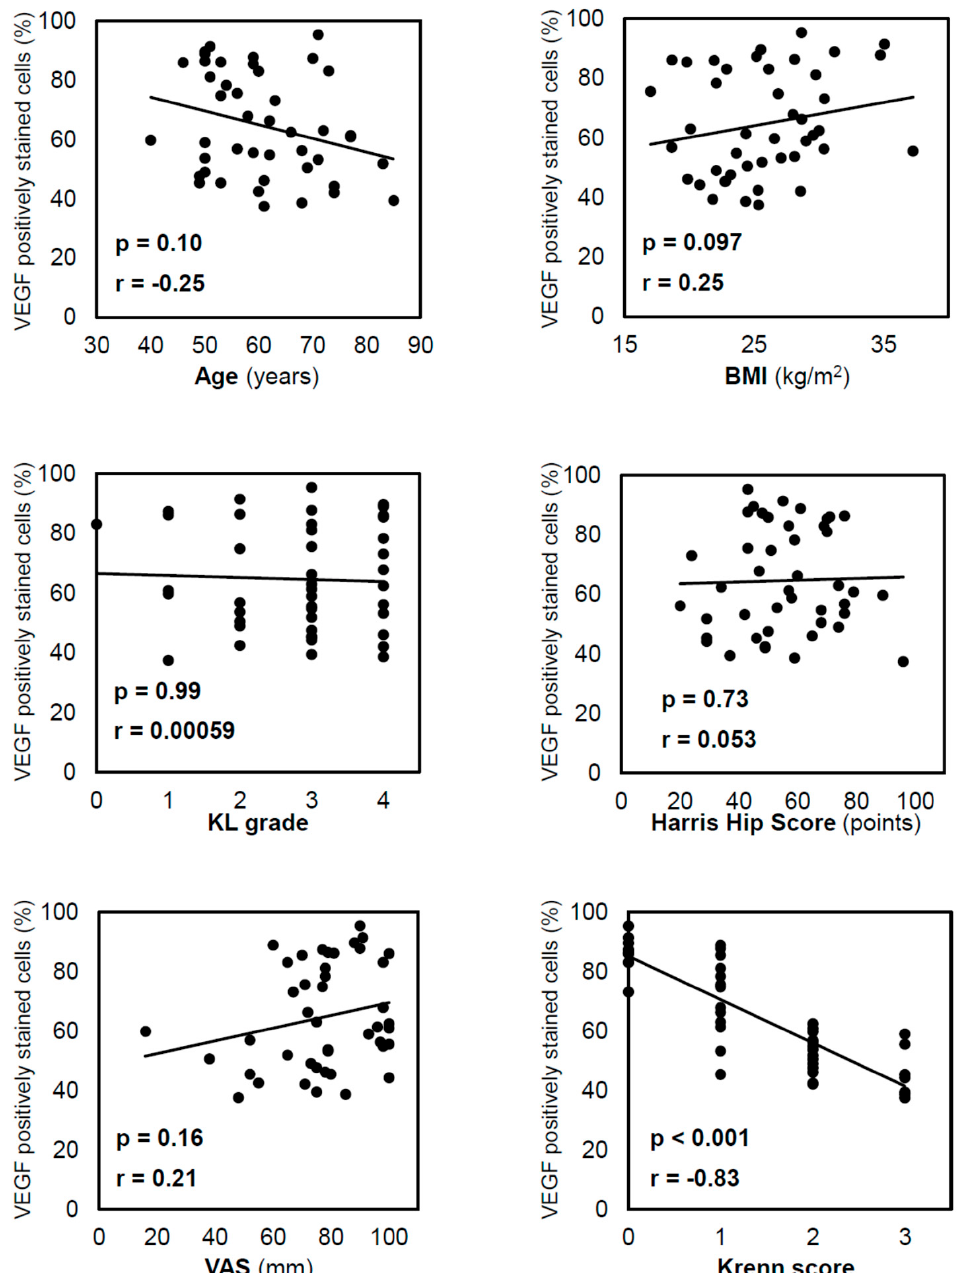
Figure 3. Correlation between VEGF-positive staining in cells in the inner region and other variables. Correlations were analysed using Spearman’s correlation coefficient. VEGF expression decreased with the progression of acetabular labral degeneration, as reflected by the Krenn score. VEGF, vascular endothelial growth factor; BMI, body mass index; KL, Kellgren–Lawrence; VAS, visual analogue scale.